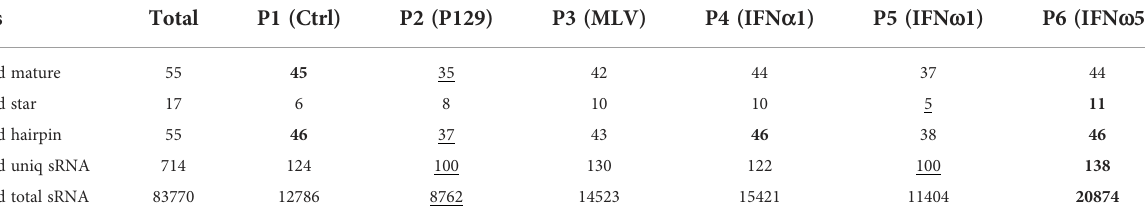
TABLE 4 Summary of novel sRNA mapped in each